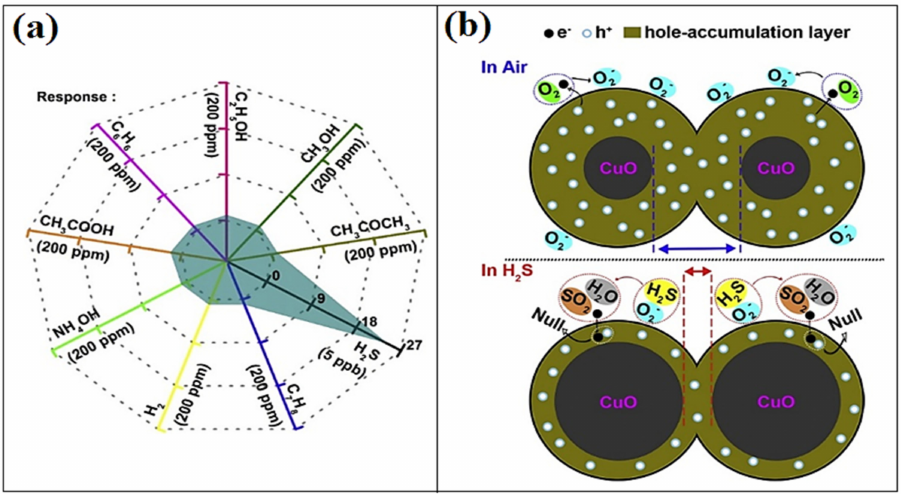
Figure 1. ( a ) Selectivity pattern of the p-CuO gas sensor prepared for 3 h to various gases at 25 ◦ C in 34% RH; ( b ) schematic of the width variation of HAL when exposed in air and H 2 S. Reprinted from [38] with permission from